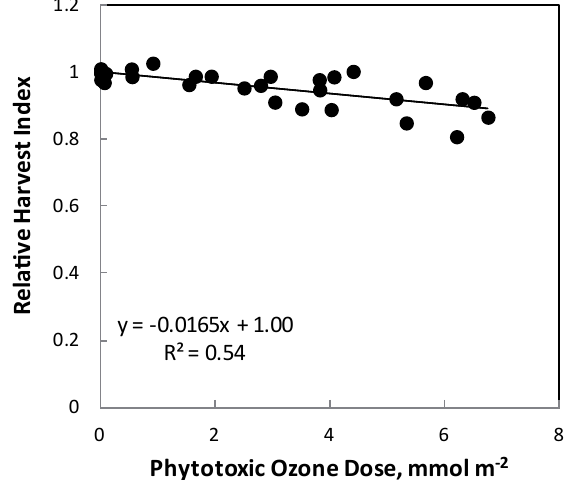
Figure 3. Relative above-ground biomass vs. Phytotoxic Ozone Dose above a threshold of 6nmolm − 2 s − 1 (POD 6 ) based on 12 experiments from 3 countries (Belgium, Finland, Sweden). The rel- ative scale is based on the assumption that there is no ozone effect on above-ground biomass at zero POD 6 in each experiment.